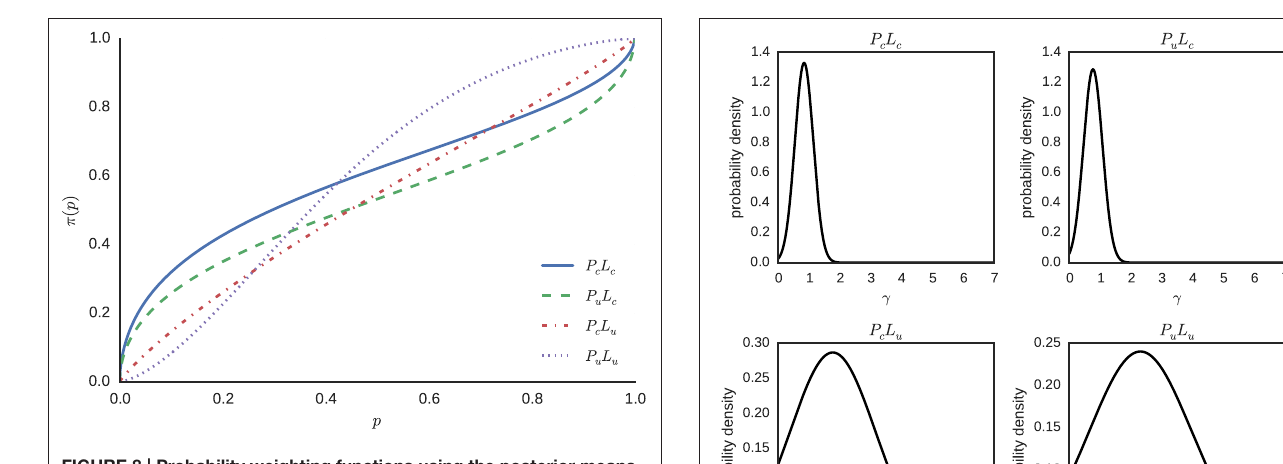
FIGURE 8 | Probability weighting functions using the posterior means for γ and p 0 .